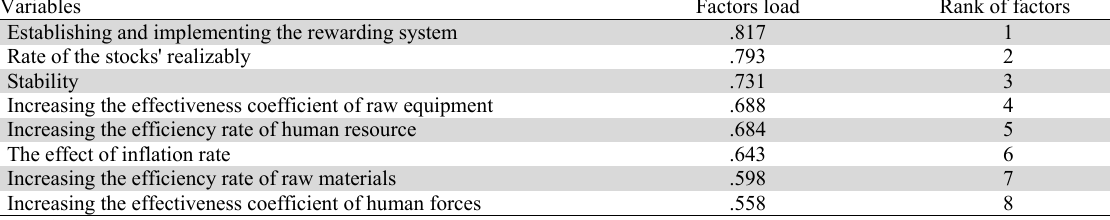
The summary of stakeholder satisfaction factors influencing on firm performance Variables Factors load Rank of factors Establishing and implementing the rewarding system